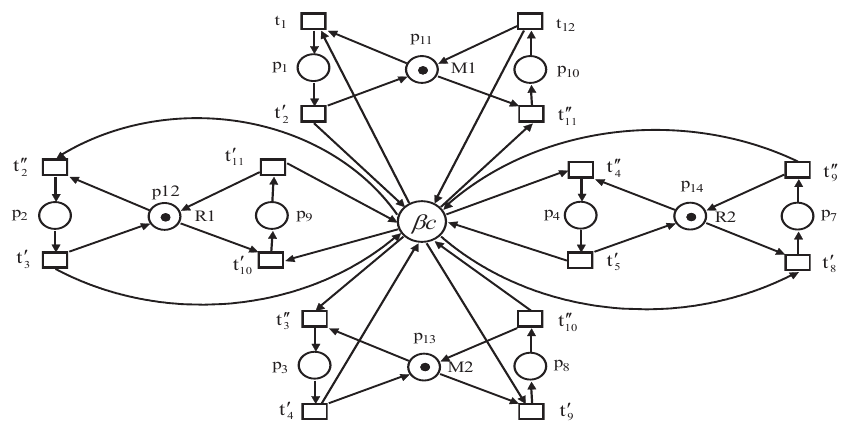
Figure 5. Petri net model with a global